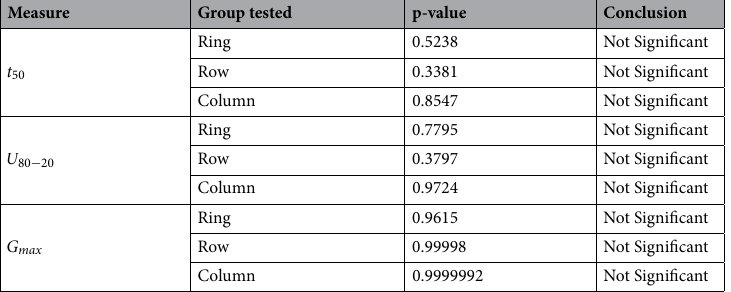
Table 1. Results of nine different tests to evaluate the edge effect risk with the Kruskal–Wallis test. The Measure column indicates the physiological index that is tested while the Group Tested column indicates which group factor (Column, Row, Ring) is assessed. The p-values are computed from 374 observations that accounts for 4804 seeds. The column Conclusion depicts that no significant edge effect has been